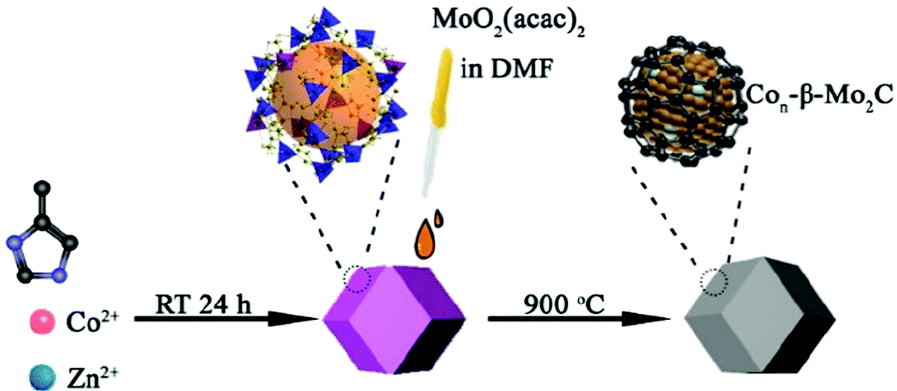
Figure 8. Schematic diagram of Co n - β -Mo 2 C@NC synthesis. Reproduced with permission from [102]. Figure 10. Schematic diagram of Co n -β-Mo 2 C@NC synthesis. Reproduced with permission from [102]. Copyright 2019 Chemical Communications (Cambridge Copyright 2019 Chemical Communications (Cambridge England).